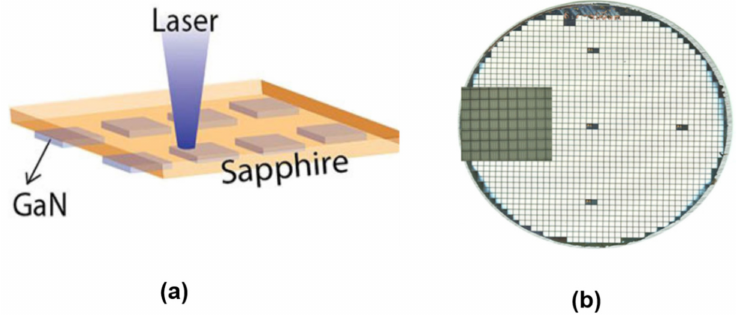
Figure 16. ( a ) Sketch of the LLO process for prepatterned semiconductor chips, ( b ) example of wafer-level LED chips released by LLO. Adapted with permission from [218]. Copyright IOP Publishing,